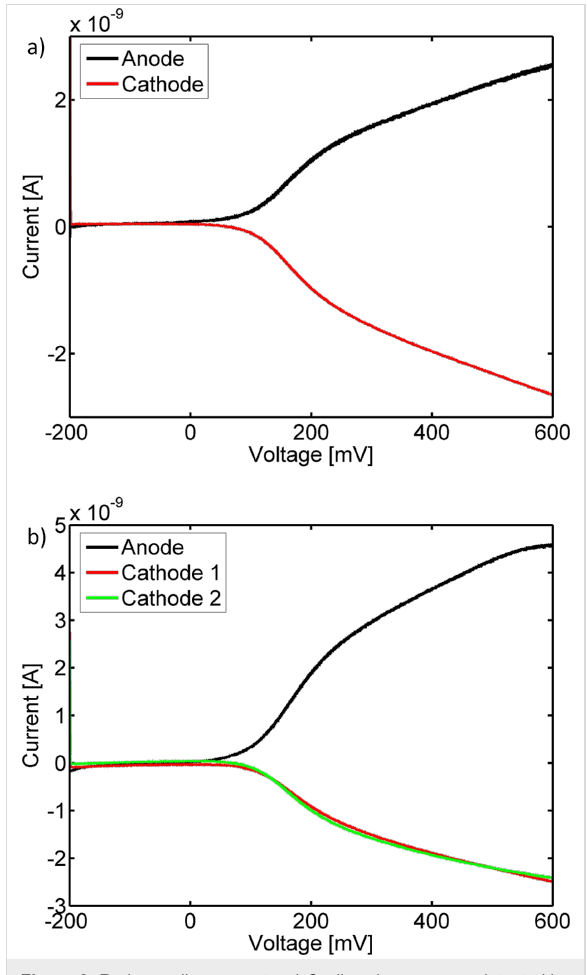
Figure 2: Redox cycling currents: a) Cyclic voltammogram detected in sequential data acquisition mode at a single intersection. b) Cyclic voltammograms recorded at two intersections during parallel acquisi- tion. Both data sets were recorded in 1 mM potassium hexacyanofer- rate in PBS and filtered via a Butterworth filter. Furthermore, the data were offset corrected and traces recorded in a single electrode